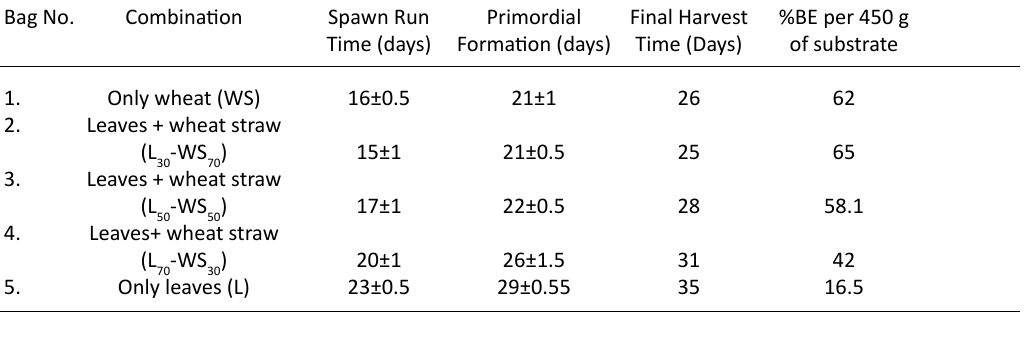
Table 2. Days took for complete mycelial colonisation, primordial formation, final harvesting, mean yield per bottle, and % BE Bag